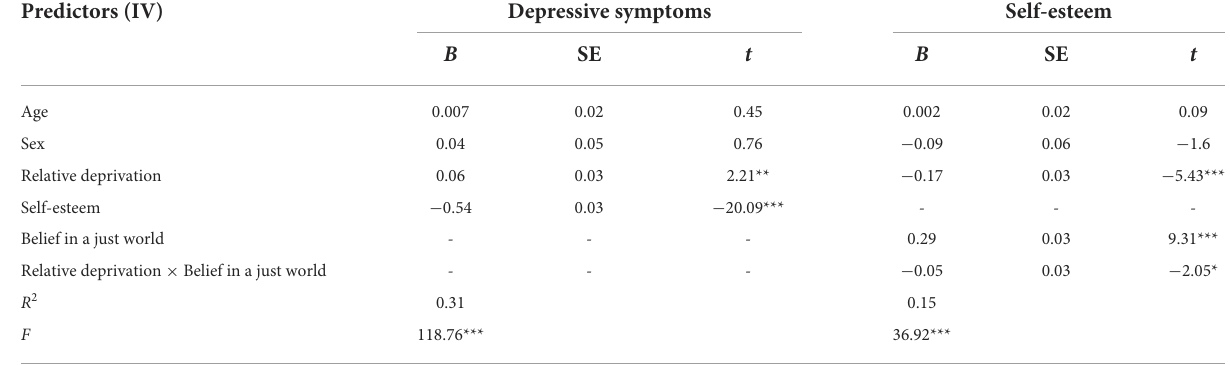
TABLE 4 Moderated mediation analysis results with belief in a just world as a moderator.